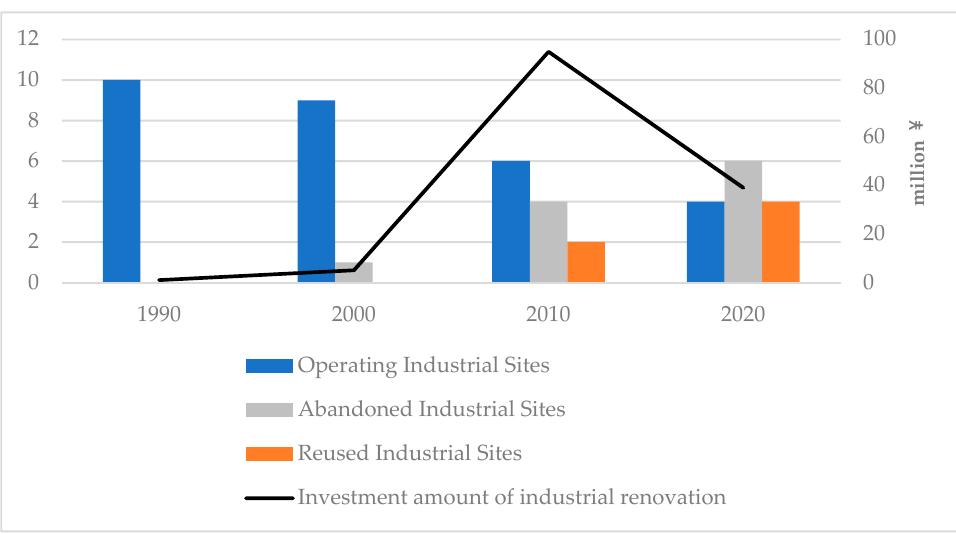
Figure 24. The change in the relationship between the operation state of technology-intensive industries and the investment amount of industrial renovation over time (Figure source: own drawing; data from: [83]).